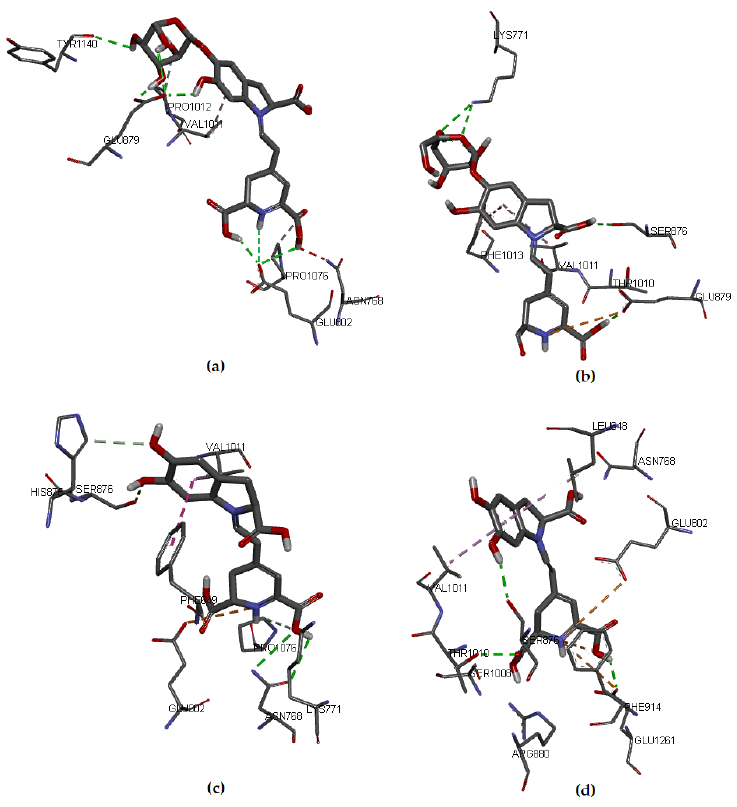
Figure 3. Molecular models of binding of compounds to active site of xanthine oxidase. A three- dimensional model (Docking): ( a ) Bn, ( b ) IsoBn, ( c ) Bd, and ( d )